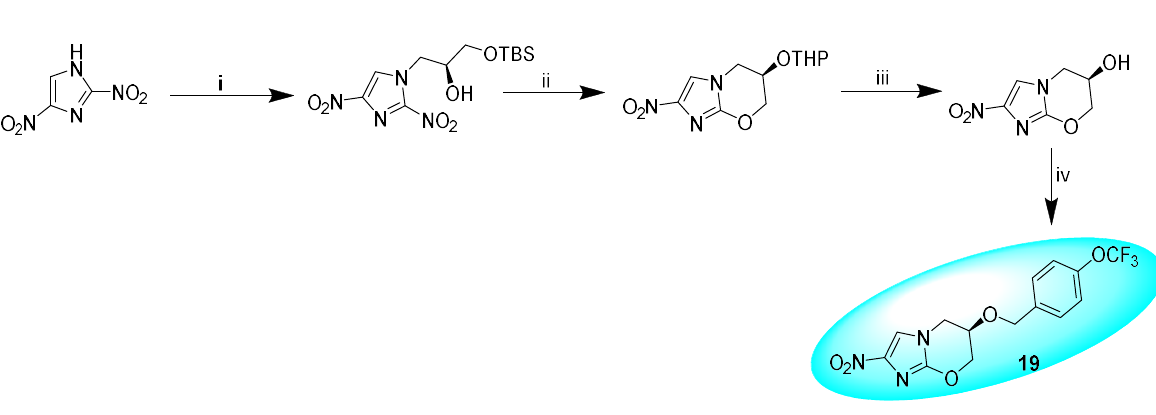
Figure 23. Activity profile of PA-824 19 [26,178,179,181].